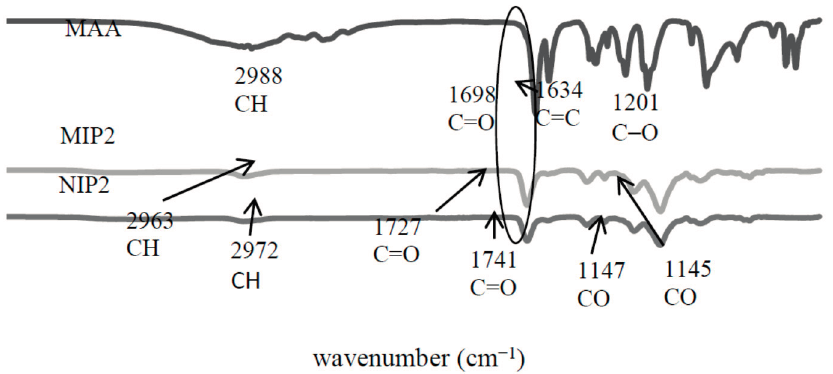
Figure 6. FTIR spectra of molecularly imprinted polymer-methacrylic acid (MIP2) and non-molecularly imprinted polymer-methacrylic acid